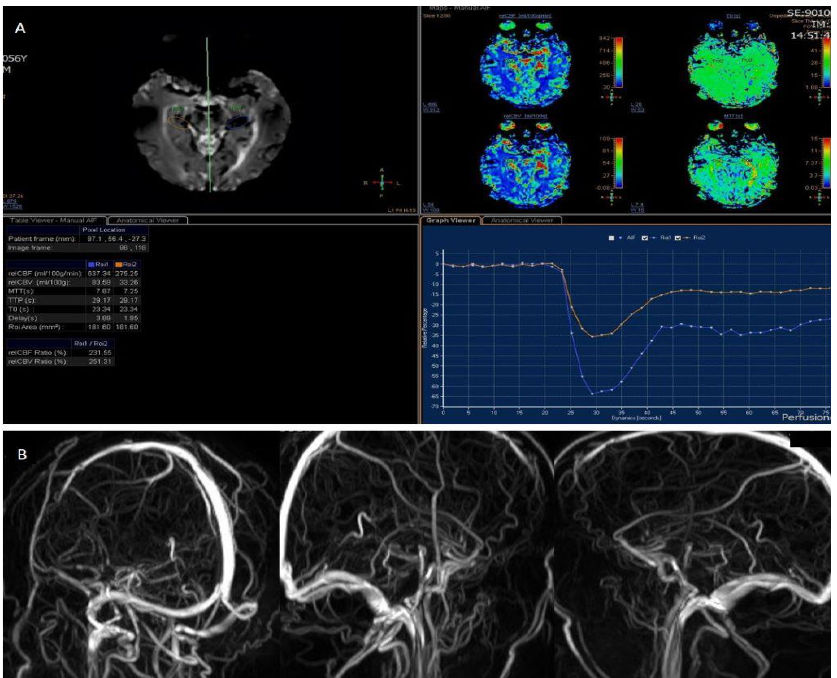
Figure 2. Perfusion weighted imaging executed using ( A ) Contrast Enhanced perfusion MRI (CEpMRI) revealed low levels of Cerebral Blood Flow (CBF, 275.25 mL/100 g/min) and Cerebral Blood Volume (CBV, 33.26 mL/100 g) in affected areas, compared to contralateral ones. ( B ) Phase Contrast Angiography (PCA)-MRA 3D Venography shows partial obliteration of straight sinus and lack of opacification of the vein of Galeno. CVT is a rare but considerable cause of stroke. It affects all ages but there is an increased incidence in older and young adults. The women-to-men ratio is 2.9–1.2. Some studies have shown rare cases of CVT related to COVID-19 infection and also to vaccination against it, in particular after ChAdOx1 nCoV-19 vaccine (AstraZeneca, Cambridge, UK); 1 of these was a multicentre cohort study which involved 43 hospitals across the UK [1]. Thromboembolic complications have been reported also in hospitalized patients with COVID-19, with a rate of 21–32%, due to a hypercoagulable state in those patients [2]. The most common clinical features of CVT are headache, papilledema, focal motor or sensory deficits and seizures [3]. There have been reported numerous causes of CVT, that can be categorized in infectious and non-infectious. Infectious causes include septic cranial trauma, meningitis, cerebritis, septicemia, otitis and sinusitis; among the non-infective aetiologies, malignancies, red cell and platelet disorders, coagulopathies and inflammatory disease deserve some recognition [4]. Symptoms and signs of CVT can be varied and not always typical. Neuroimaging tools play an important role in diagnosing CVT and therefore also in ensuring a timely therapeutic intervention [5].